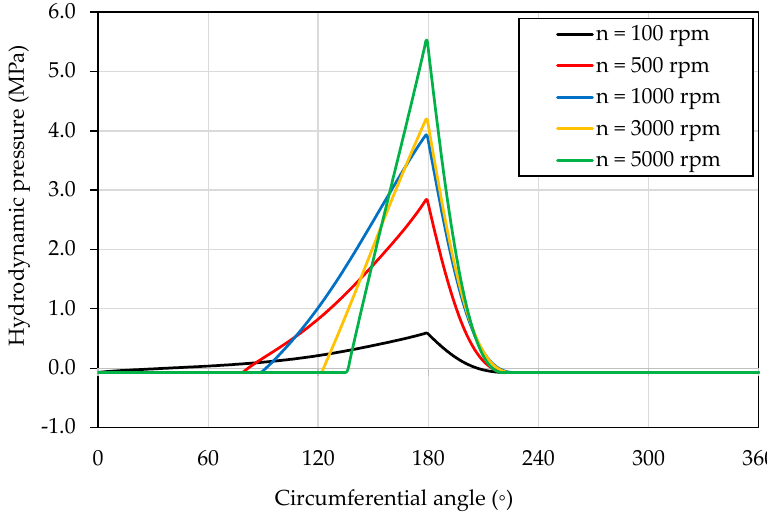
Figure 13. Hydrodynamic pressure profile of the heterogeneous slip/no-slip bearing for different rotational velocity n . All results are evaluated at z / L = 0.5.